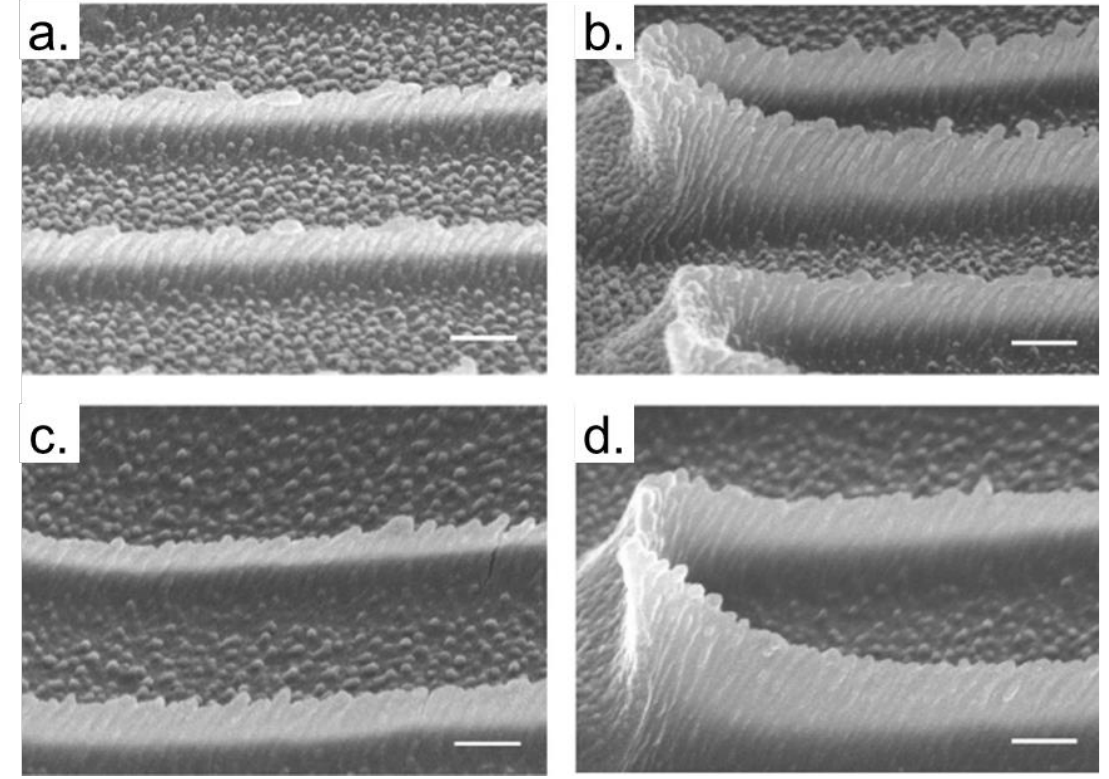
Figure 20. Replication of nanograss. ( a , b ) SEM images of the master nanograss. ( c , d ) nanograss replica. Scale bars, 200 nm. Reproduced with permission [157]. Licensed under a Creative Commons Attribution 4.0 International license.